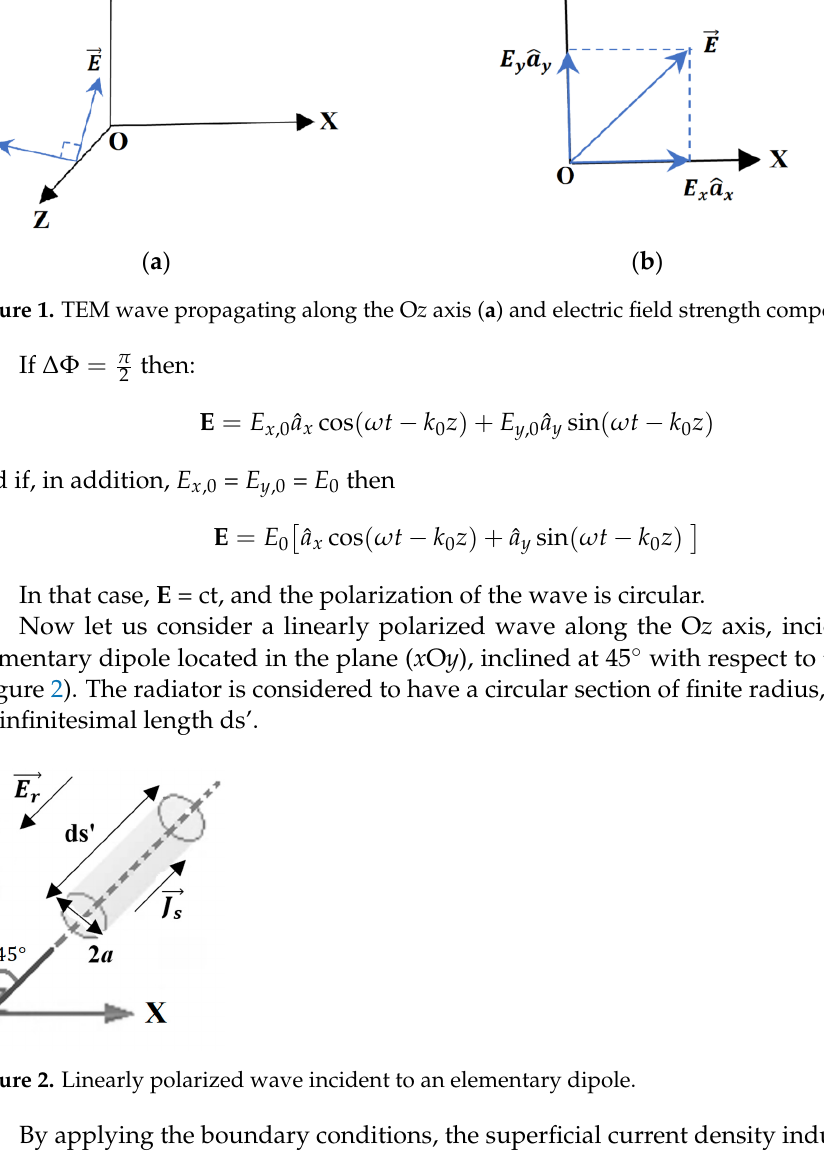
and the induced current can be found by integrating the current density on the side surface of the